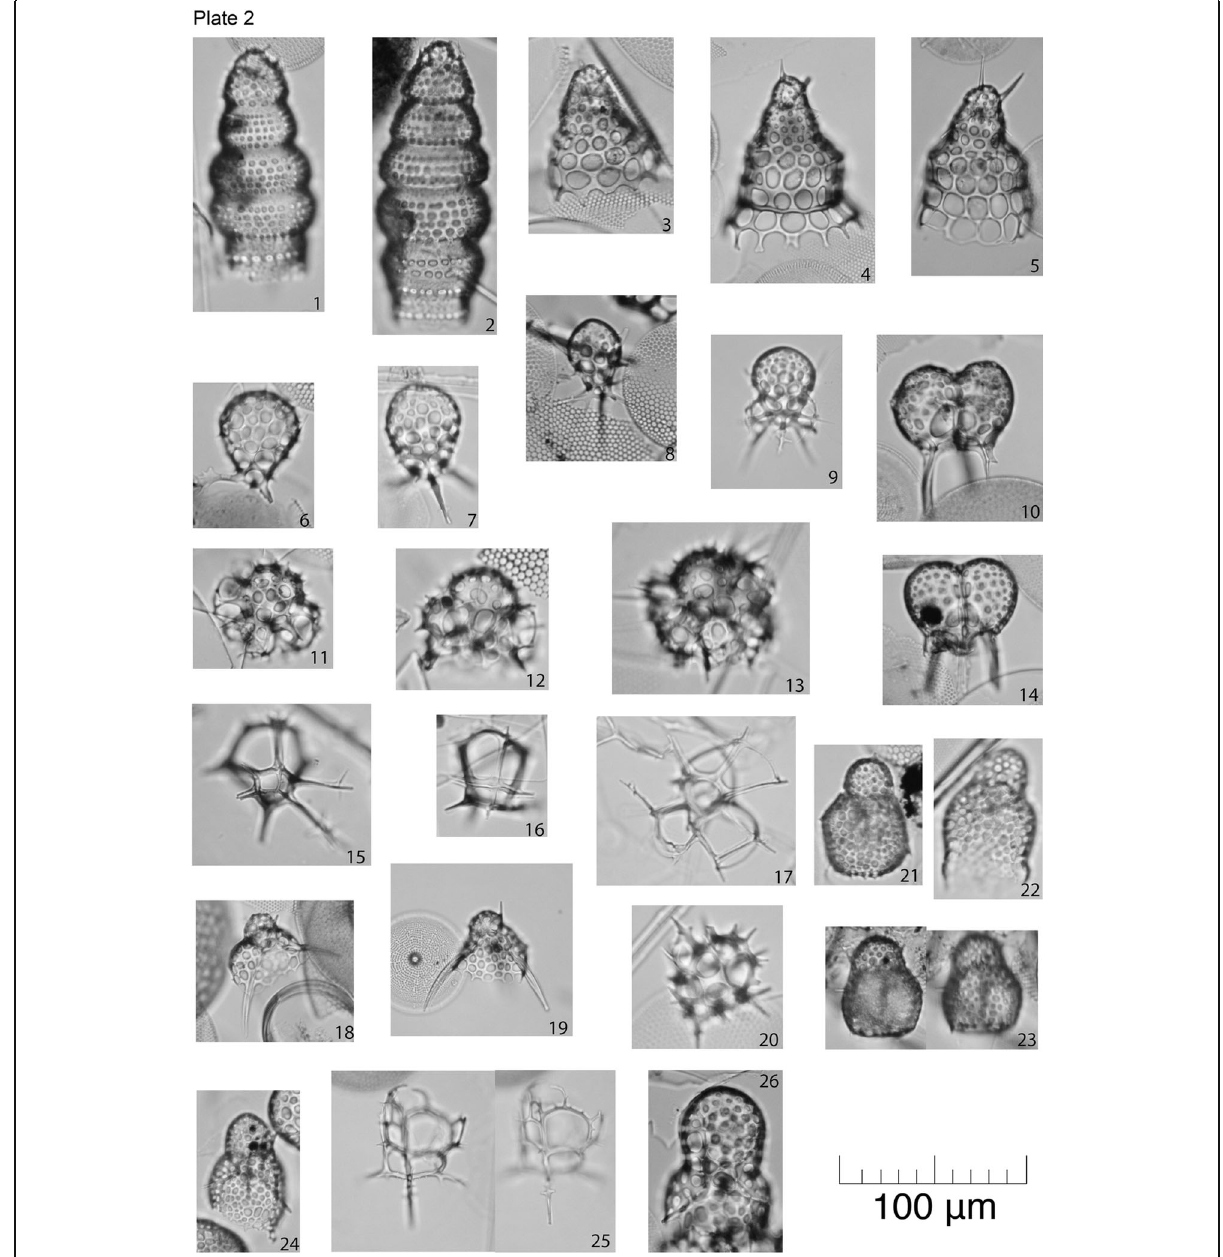
Fig. 3 Key Nassellarian species encountered at Site U1429. 1 – 2 Botryostrobus auritus (Ehrenberg) (sample 346-U1429A-7H6-27-29 cm); 3 – 5 Cycladophora davisiana Ehrenberg (sample 346-U1429C-10H4-27-29 cm); 6 – 9 Arachnocorallium calvata Petrushevskaya group (sample